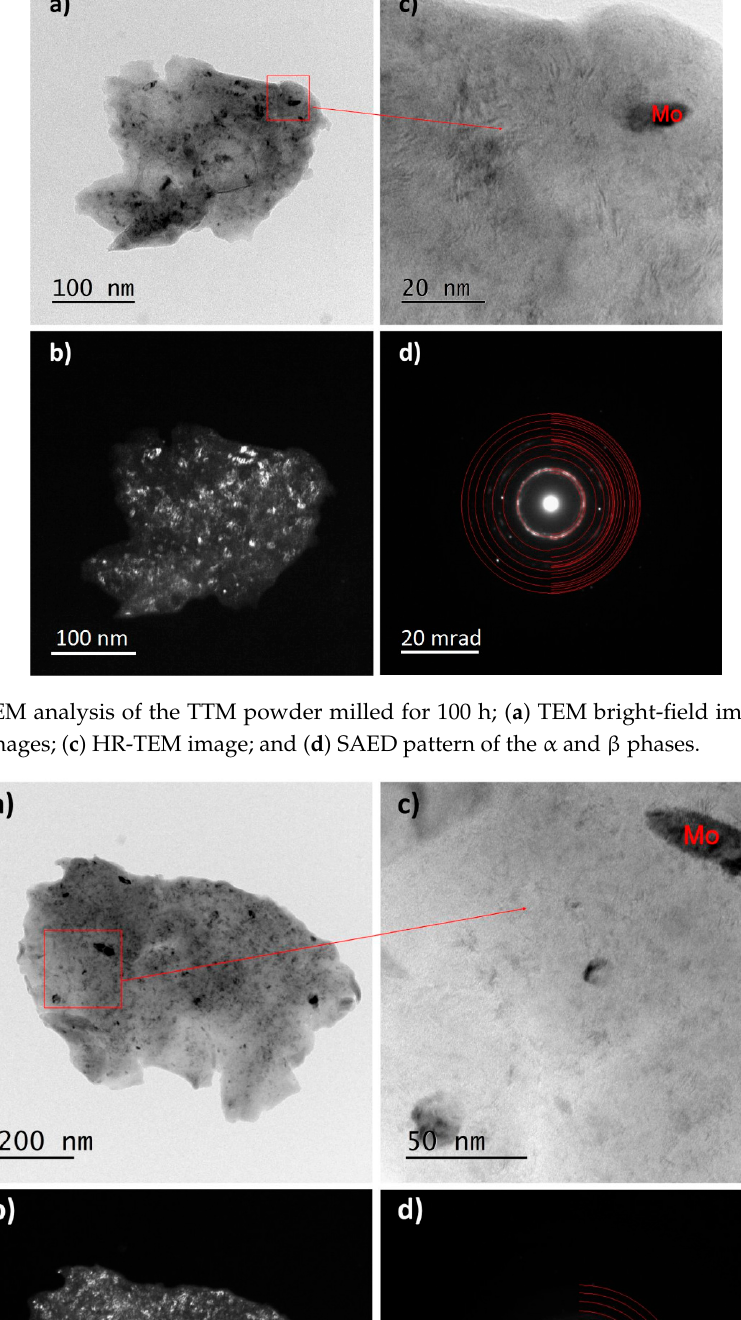
Figure 8. TEM analysis of the TTM powder milled for 100 h; ( a ) TEM bright ‐ field image; ( b ) TEM dark ‐ field images; ( c ) HR ‐ TEM image; and ( d ) SAED pattern of the β phase.